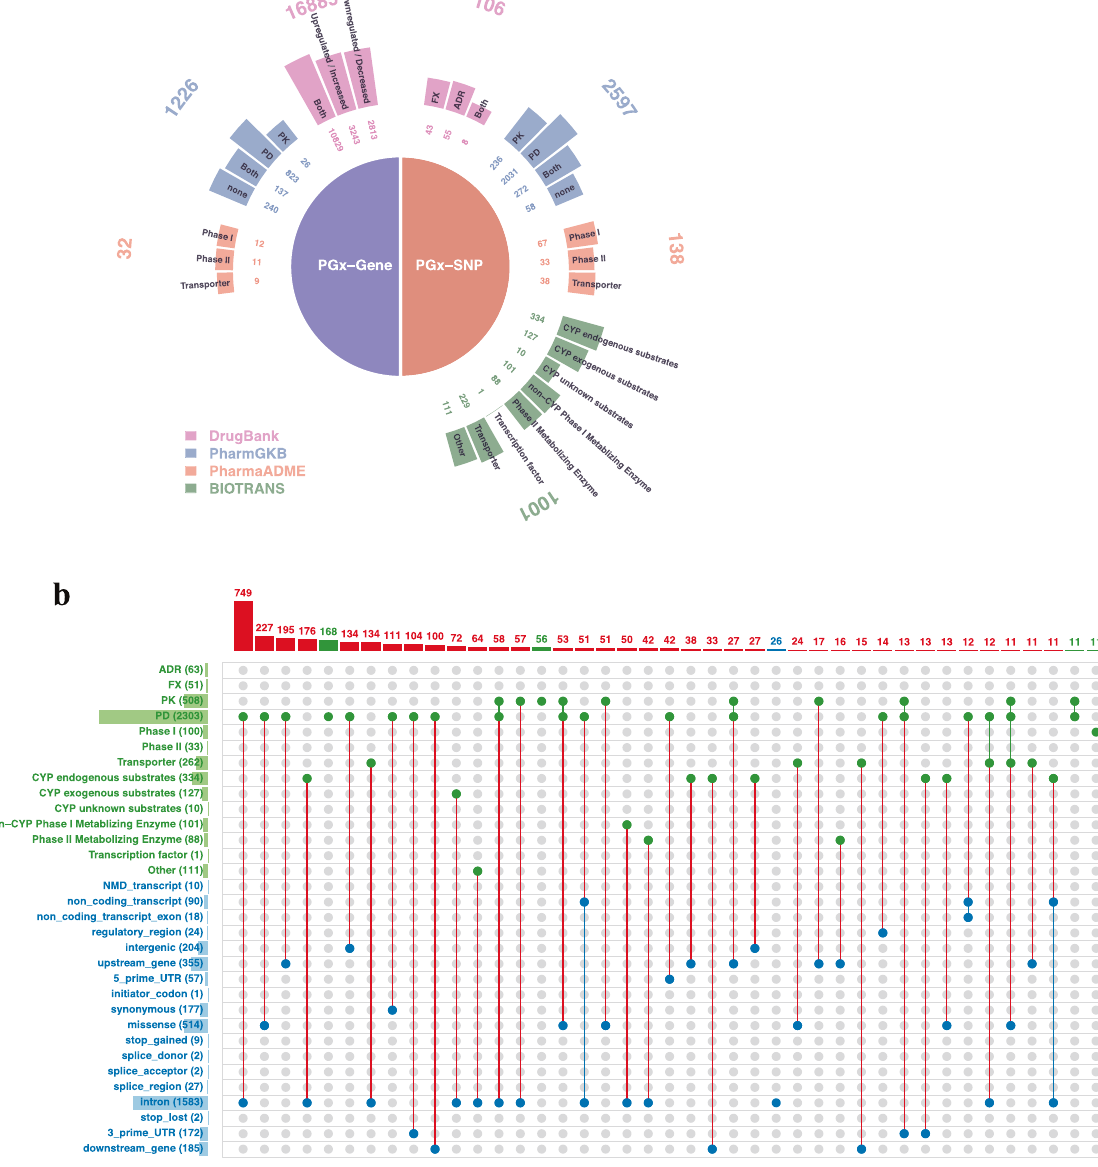
Fig. 2 Distribution of PGx in four public resources. a This study collected PGx from four PGx resources: Drug Bank, PharmGKB, PharmaADME, and Biotransformation. b Relationship between drug category and functional annotation of PGx. Red lines indicate a relationship between drug category and functional annotation. Green lines indicate a relationship between multiple drug categories. Blue lines indicate a relationship between multiple functional annotations. Histograms of PGx for drug category (green bar) and functional annotation (blue bar) are displayed on the left-hand side. Histograms of PGx for all relationships are displayed at the top; only the relationships with a frequency of >10 are